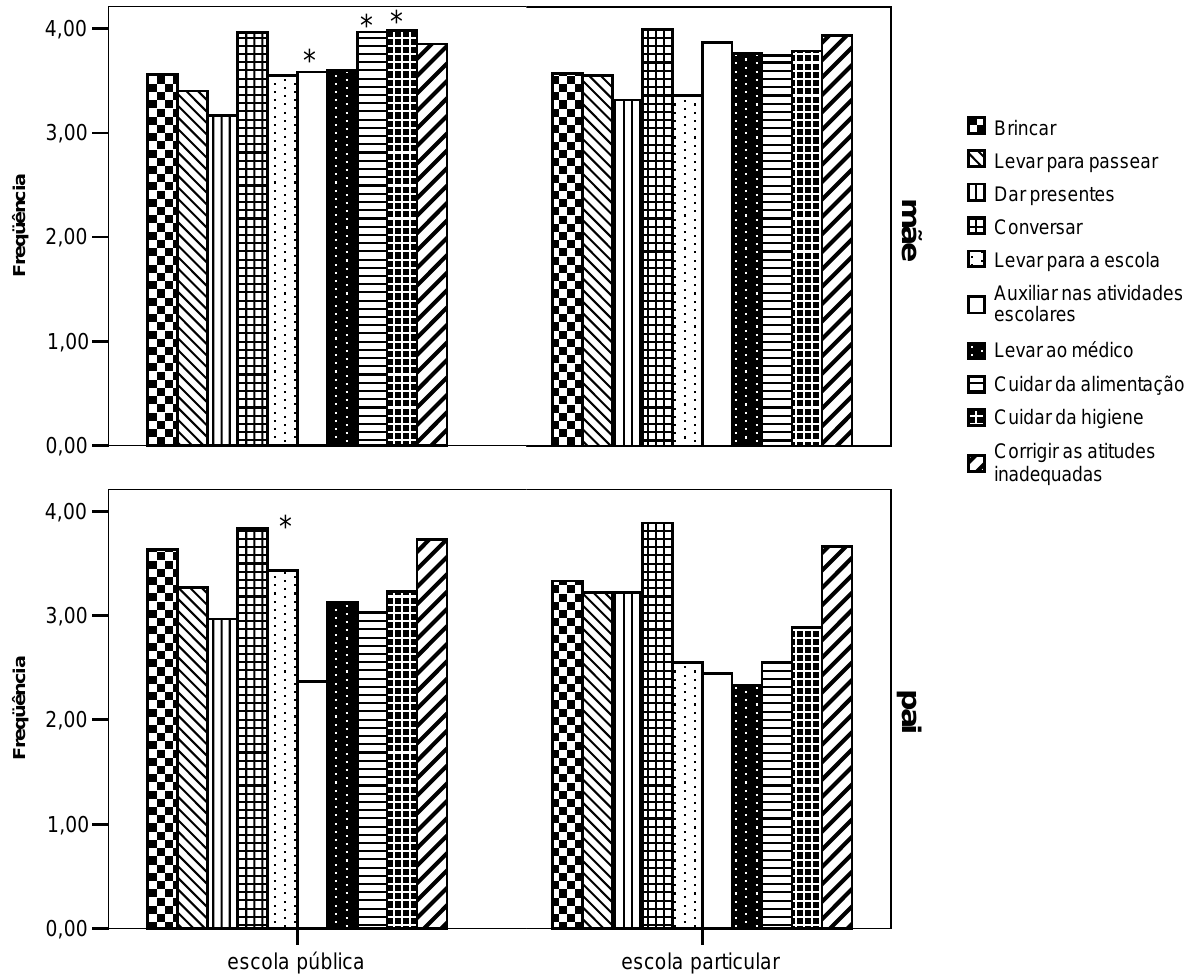
Figura 1. Freqüência: (1 - não realiza, 2 - realiza poucas vezes, 3 - realiza às vezes, 4 – realiza muitas vezes) com que pais e mães de crianças matriculadas em escolas públicas e particulares declararam realizar cada atividade com seus filhos. Os asteriscos indicam diferenças significativas ( α <0,05) entre os cuidadores das crianças matriculadas nas escolas públicas e particulares.